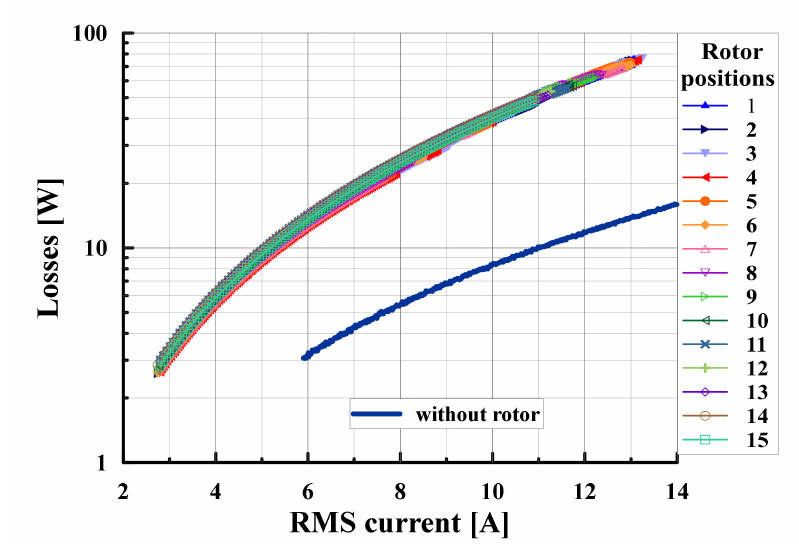
Figure 14. Stator losses as a function of current at different rotor positions at a frequency of 200 Hz. Same frequency without rotor is depicted for reference.